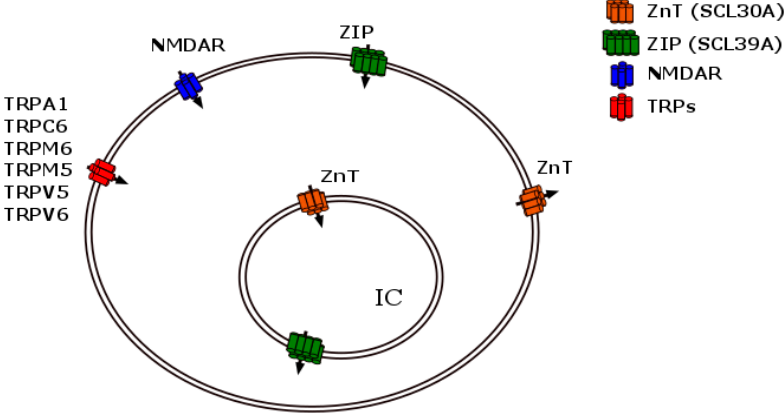
Figure 3. Extra and intracellular zinc transporters. The graphic summarizes multiple zinc carriers; among them several TRP channels, NMDA receptors, and the ZIP and ZnT zinc transporter families. While the influx of zinc relies on the first three families of proteins, the efflux is mediated by the ZnT transporters. TRPs and NMDAR are exclusively localized in the extracellular membrane. Both families of zinc transporters are localized in the extra- and intracellular organelle membranes, represented in this figure by a single compartment, IC. Intracellular organelle membranes may include synaptic vesicles, lysosomes, endosomes, vesicular granules (insulin-storing vesicles) and the Golgi complex.